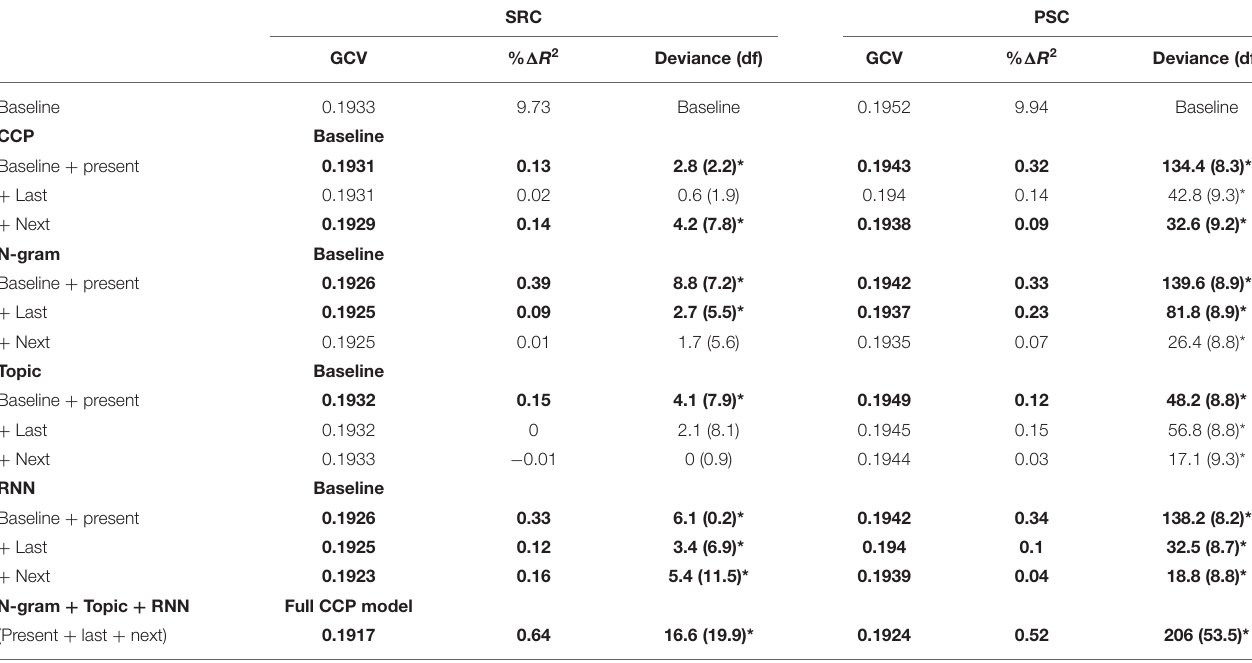
TABLE 6 | Generalized additive models (GCV, R 2 ) for total viewing time (TVT) and χ 2 tests (df) against the previous model for significant increments in explained variance (* p <